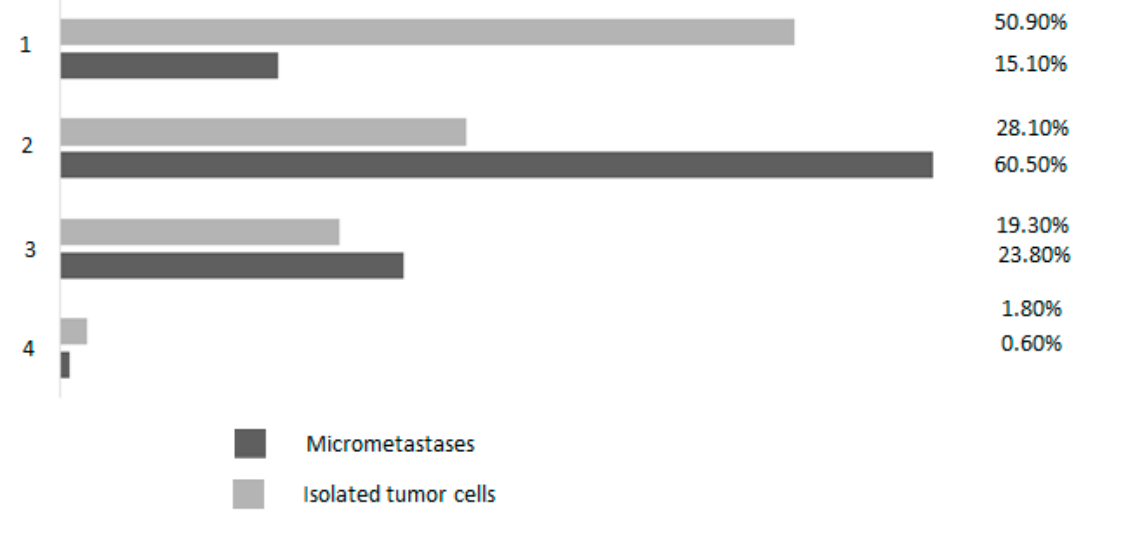
Figure 2. Management after detection of micrometastases (black bars) and management after detection of isolated tumor cells in sentinel nodes (grey bars) in the percentage of respondents. 1 = no further procedures, as the prognostic relevance is unclear; 2 = ipsilateral IL; 3 = ipsilateral radiation without surgical intervention; 4 = individualized procedure.